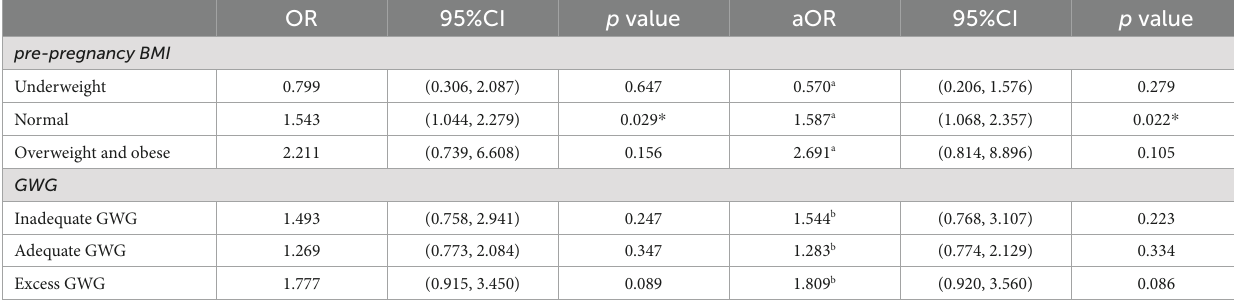
TABLE 4 Correlation between maternal second-trimester stress and PROM according to pre-pregnancy BMI and GWG. OR 95%CI p